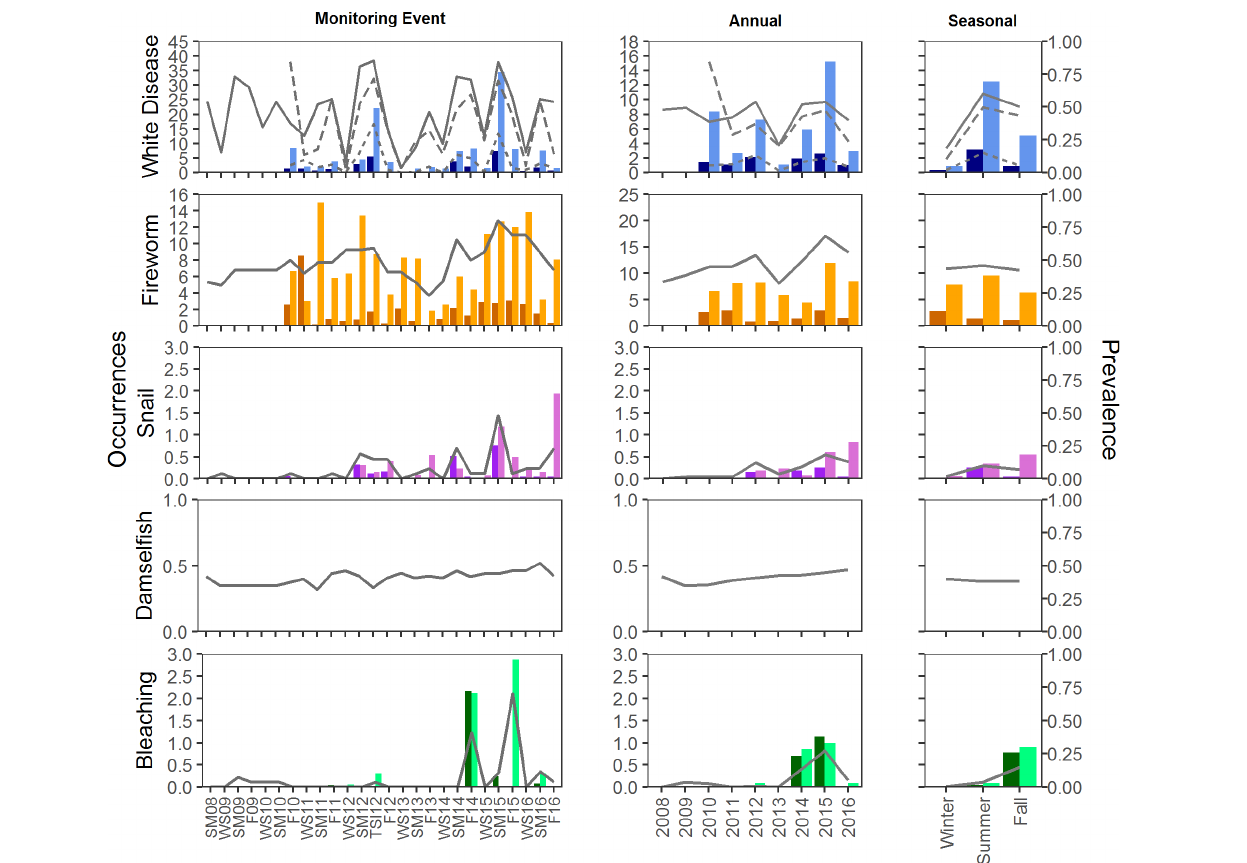
FIGURE 5 | Mean prevalence and occurrence of disease, predation, and bleaching by plot at BCA. Prevalence is indicated by the lines on each graph; solid lines represent prevalence of plots with condition. For disease, dotted and dashed lines represent prevalence on colonies and masses, respectively. Occurrences of each condition were counted on colonies (dark bars) and masses (light bars). Occurrences were not counted for Damselfish